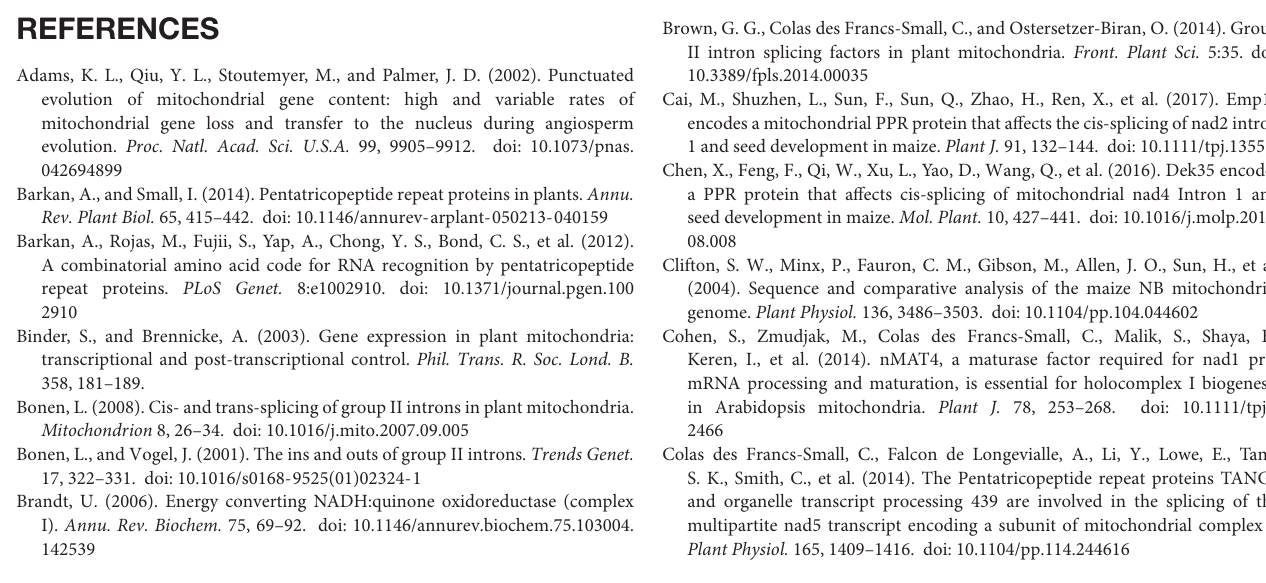
Supplementary Figure 1 | Clone and linkage analysis of Emp24 and Emp25 . Supplementary Figure 2 | Allelism test of emp24 and emp25 . Supplementary Figure 3 | Transcript level analysis of Emp25 in mutants and different organs and developing seeds in maize. Supplementary Figure 4 | The editing profiles of nad5 in WT and emp25-1 . Supplementary Figure 5 | cRT-PCR analysis of the 5 (cid:48) /3 (cid:48) ends of nad5 transcripts in WT and emp25-1 . Supplementary Figure 6 | The assembly of the mitochondrial CIII, IV, and V and respiratory rate comparison in WT and emp25-1 . Supplementary Figure 7 | Binding sites prediction of EMP25. Supplementary Figure 8 | Major results of emp24 . Supplementary Figure 9 | The editing profiles of nad4 in WT and emp24-1 . Supplementary Table 1 | Peptides of CI identified details in MS analysis. Supplementary Table 2 | Primers used in this